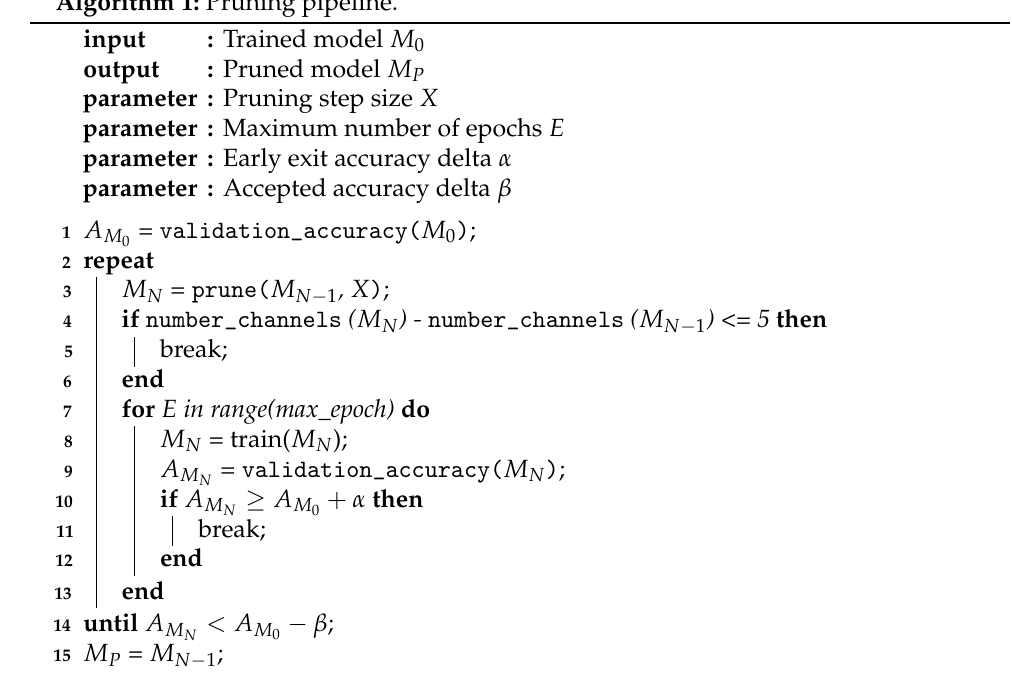
Algorithm 1: Pruning